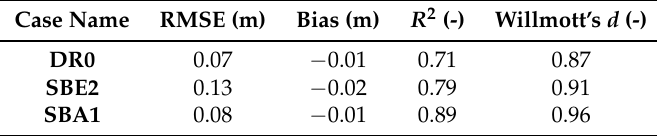
Table 4. RMSE, bias, R 2 , and Willmott’s index of agreement d for η s